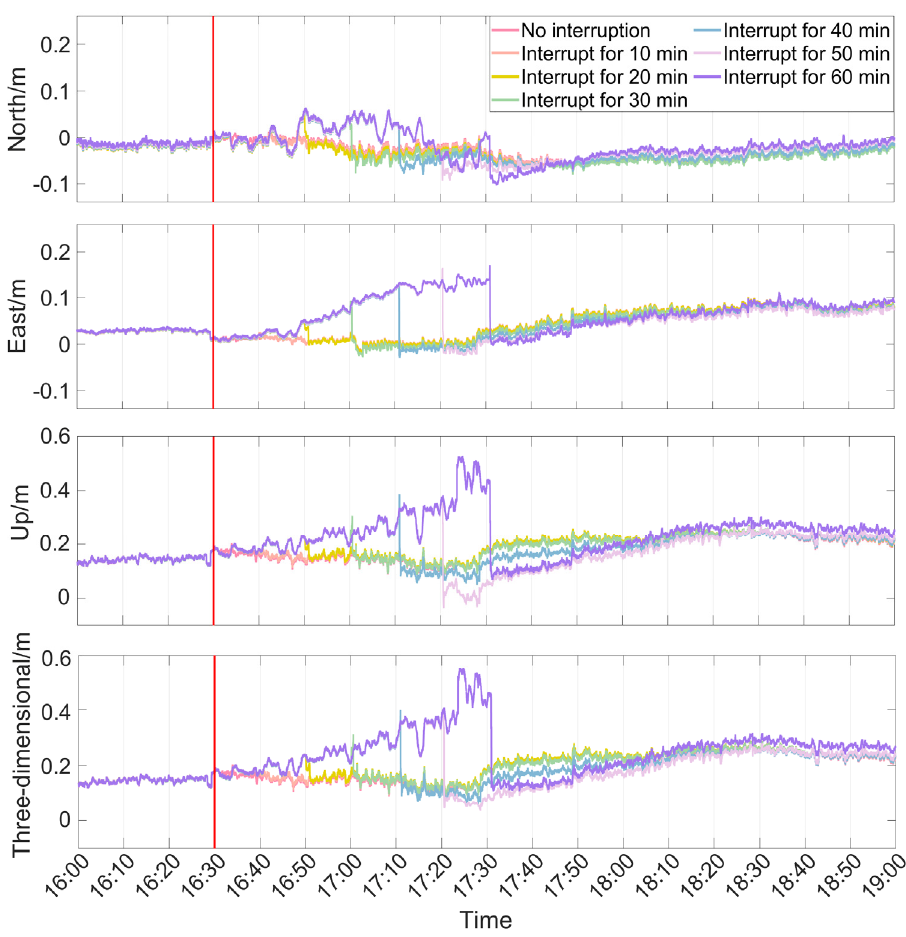
Figure 13. Effects of different interruption lengths on the simulated kinematic PPP-B2b positioning results for the BJ01 station in the north, east, up, and 3D directions on DOY 279 in 2022.